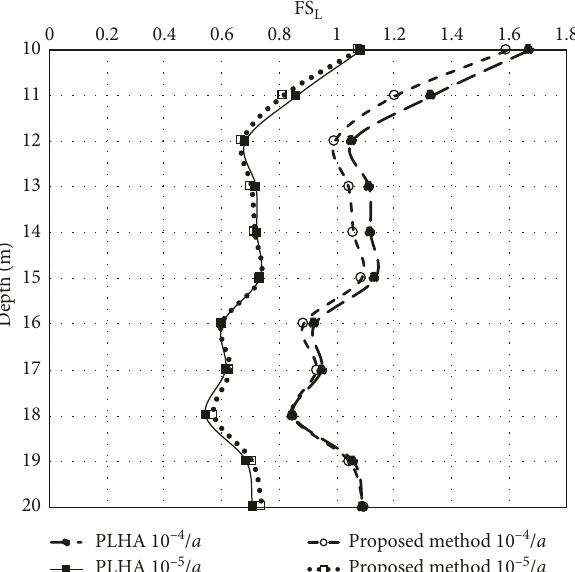
Figure 7: Comparison of FS L distribution versus depth calculated by PLHA and the proposed pseudoprobabilistic method for 10 10 − 5 / a levels.